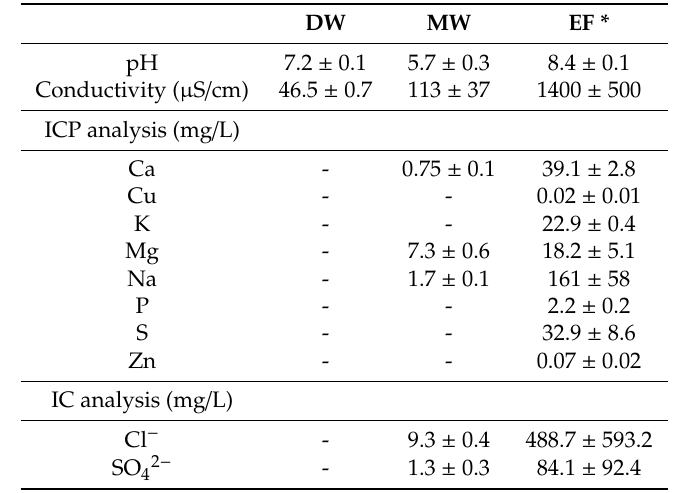
Table 1. Characterization of the environmental matrices under study.